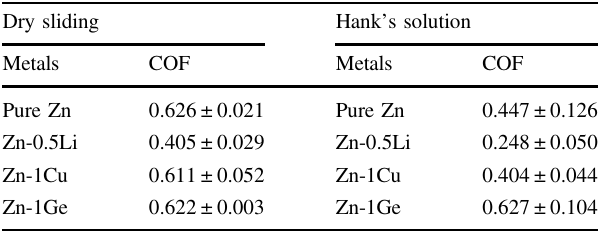
Table 1 The Mean coef fi cient of friction (COF) of four metals under dry sliding condition and in Hank ’ s